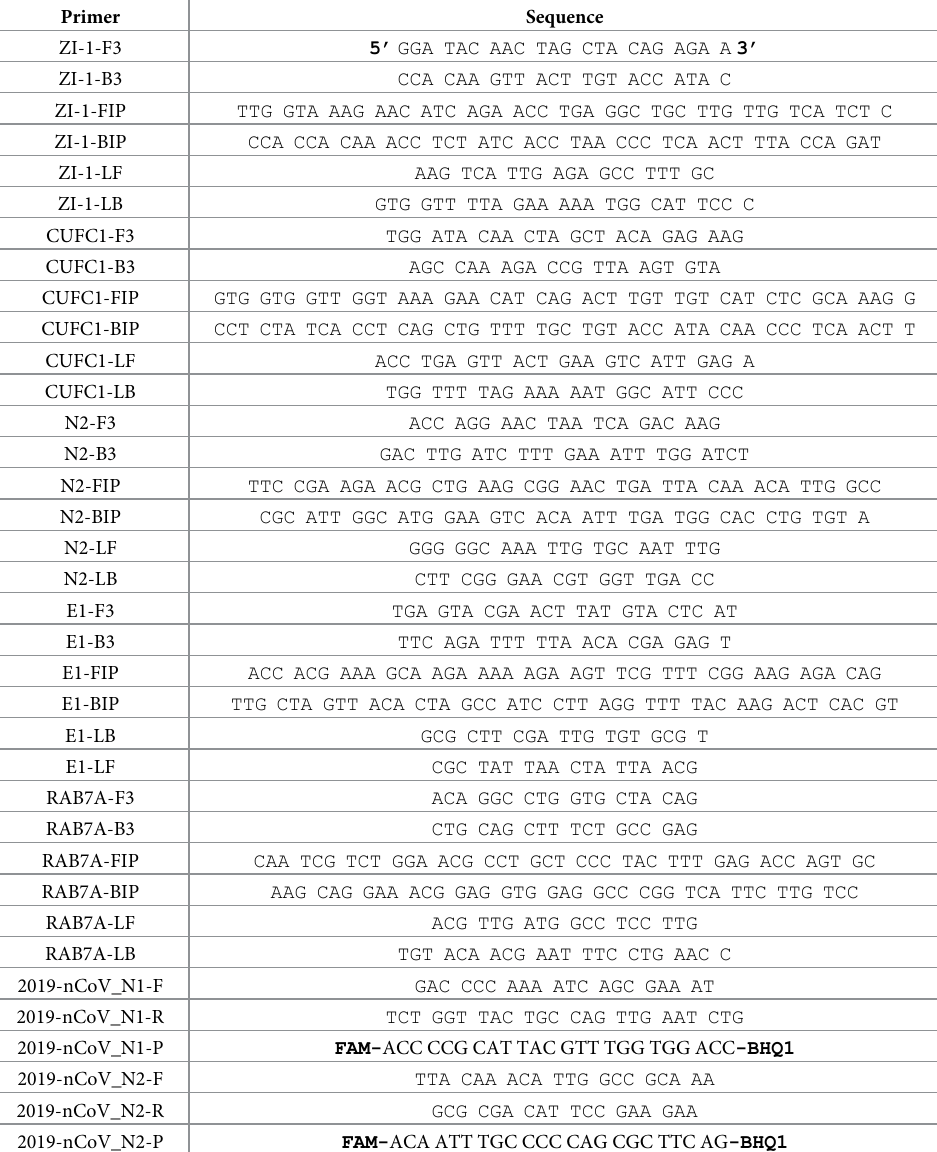
Table 2. Primers used in